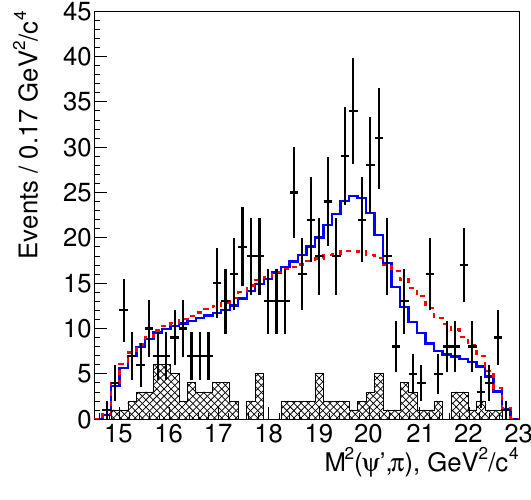
Figure 1. Projections of the ¯ B 0 → ψ (2 S ) π + K − fit results onto M 2 . The points with error bars are ψ (2 S ) π + the data, the hatched histogram is the background, the blue solid line is the fit with the Z c (4430) + , and the red dashed line is the fit without its contribution. The narrow K ∗ veto is applied: | M K − π + − m K ∗ (892) | > ∗ | > 100 MeV, where m 100 MeV and | M K − π + − m K ∗ K ∗ are the nominal masses of the specified K 2 (1430) resonances. Figure from reference